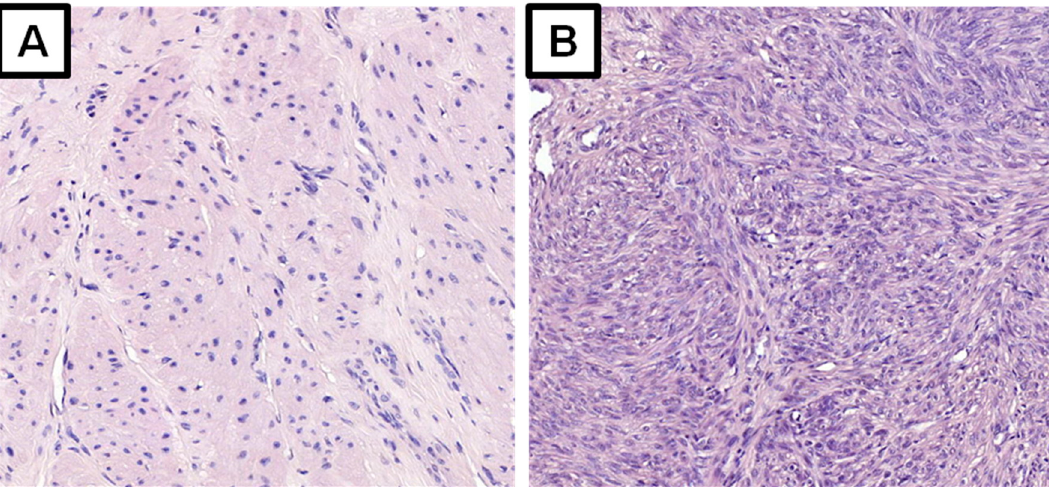
Figure 1. Microscopic slides, histologic specimens of the myometrium ( A ) and a uterine fibroid ( B ). Hematoxylin and eosin stain, 200× magnification.